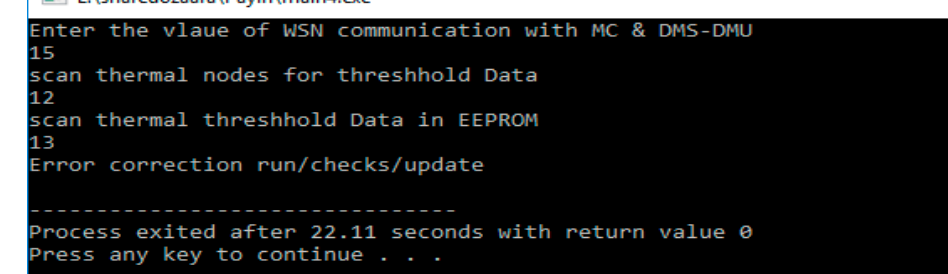
Figure 6. Critical alert minimum temperature below 15 °C.